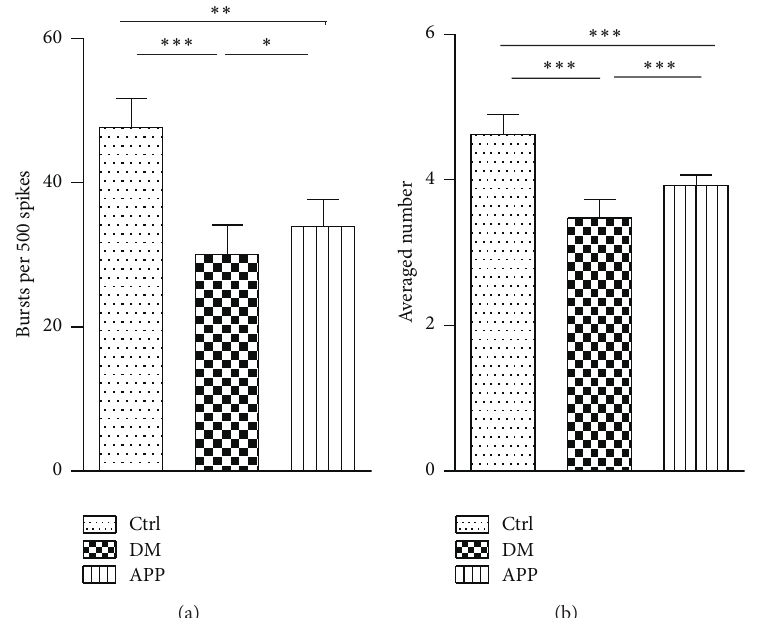
Figure 4: Comparison of burst ratio and number of spikes within burst between groups. The burst ratio of neurons from diabetic rats ( 𝑛 = 26 ) is significantly lower than that of control rats ( 𝑛 = 59 , 𝑃 < 0.001 , Mann-Whitney test). Decrease of the number of spikes within bursts in diabetic rats was also observed ( 𝑃 < 0.001 , Mann-Whitney test). Compared to that of diabetic rats, APP 17-mer peptide increased the burst ratio and number of spikes within bursts ( 𝑛 = 35 , 𝑃 < 0.05 for burst ratio; 𝑃 < 0.001 for number of spikes within bursts, Mann-Whitney test) but still had significant difference with control rats ( 𝑃 < 0.01 , Mann-Whitney test, for burst ratio; 𝑃 < 0.001 for number of spikes within bursts). “ 𝑛 ” represents number of